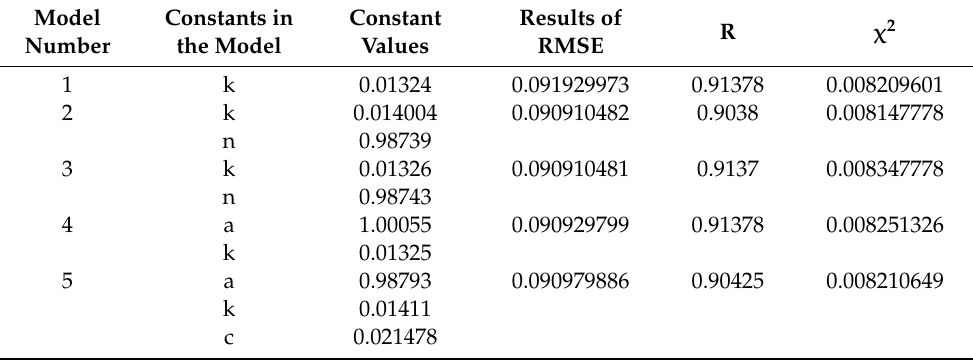
Table 7. Statistical analysis results of 12 models applied to MR